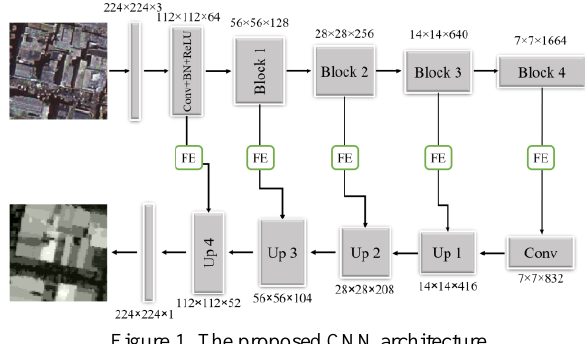
Figure 1. The proposed CNN architecture